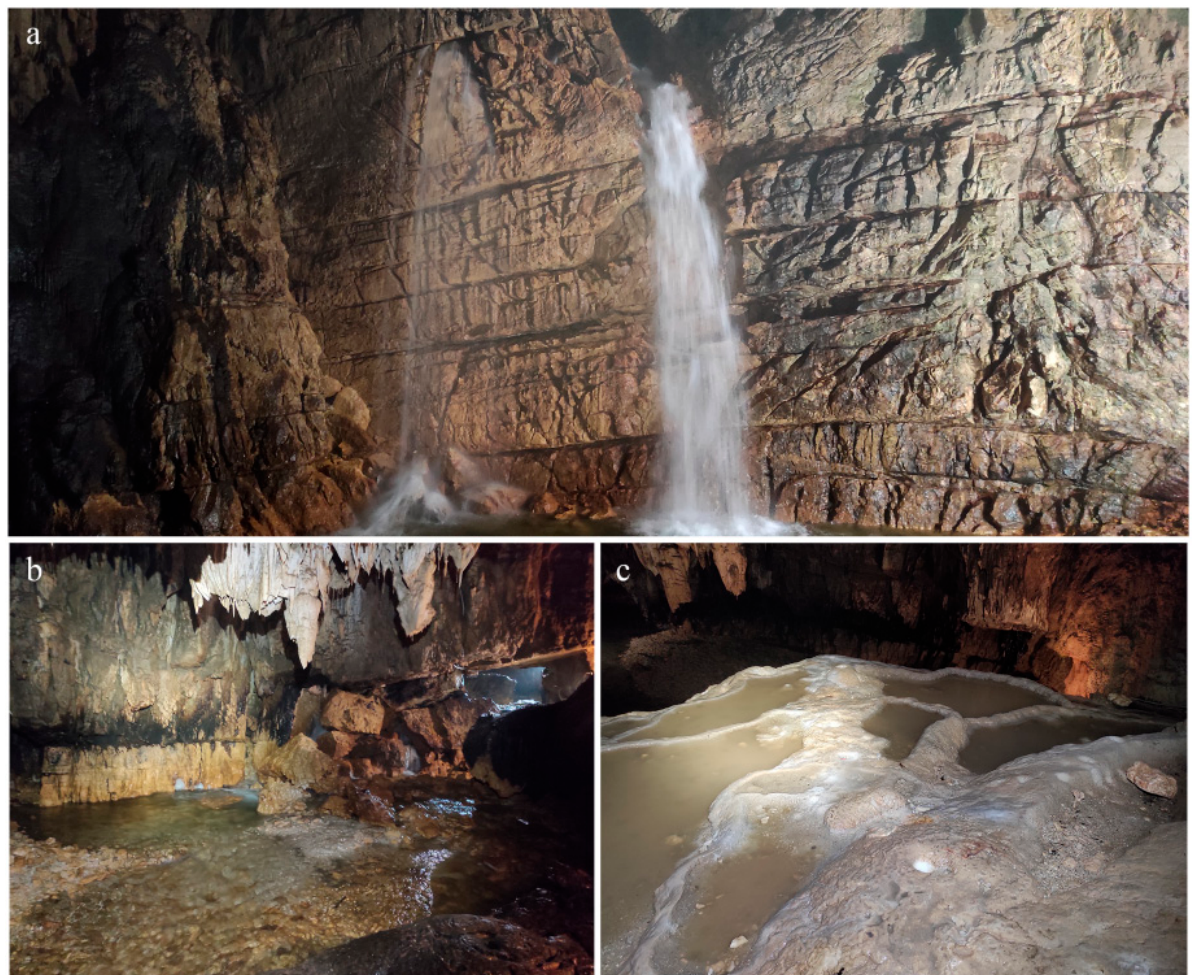
Figure 3. Pictures showing some of the main features of the sampling sites in Stiffe Cave: ( a ) waterfall close to SC_b5; ( b ) SC_b2; ( c ) concretional dripping pools SC_cp1.